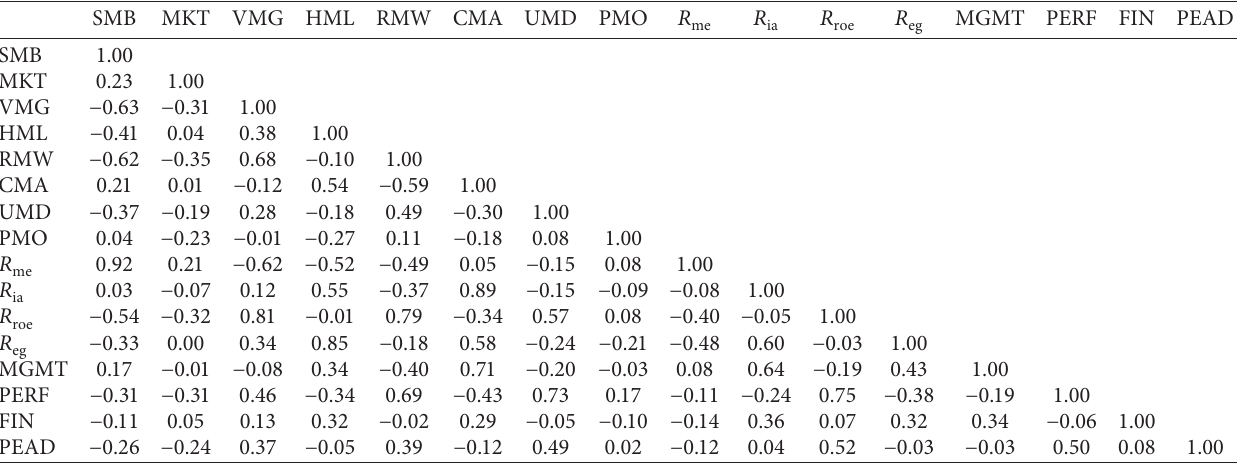
Table 3: Correlation matrix of pricing factors. This table displays the correlation matrix of mainstream pricing factors. The sample period is from July 2000 to December 2019. MKT, SMB, VMG, and PMO are market, size, value, and turnover factors in the Liu–Stambaugh–Yuan 4- factor model [15]. HML, RMW, CMA, and UMD are value, profitability, investment, and momentum factors in the Fama–French 6-factor model [10]. R , R , R , and R are size, investment, profitability, and expected growth factor in the Hou–Xue–Zhang q5-factor model [2]. me ia roe eg MGMT and PERF are two mispricing factors in the Stambaugh–Yuan 4-factor model [21]. PEAD and FIN are two long-short horizon factors in the Daniel–Hirshleifer–Sun 3-factor model